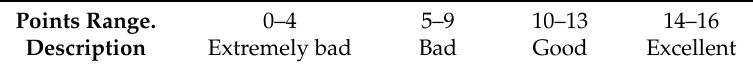
Table 2. Ranges of the wellness evaluation points and their description. Points Range.